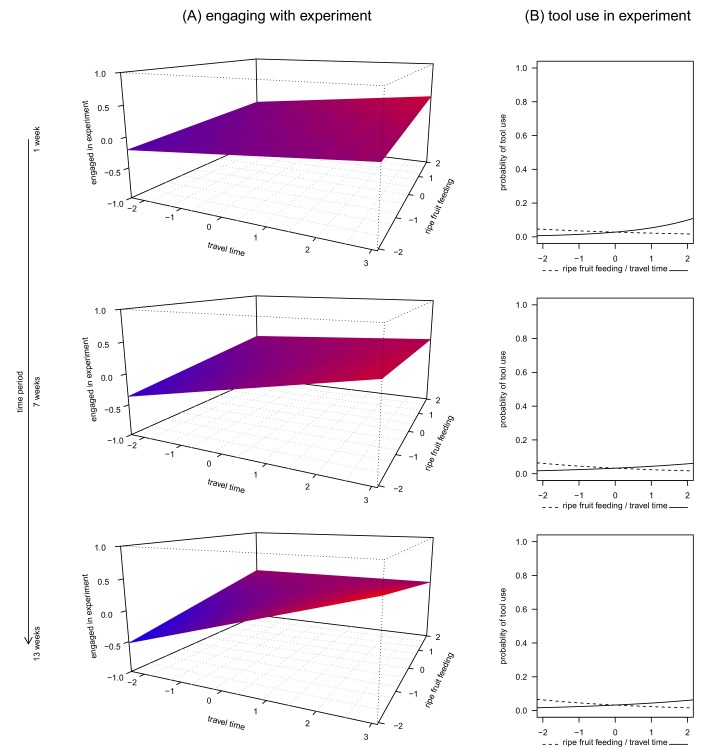
The relationship between ripe fruit feeding, travel time, time period and engagement in the honey experiment (A, Figure 1—source data 1) and ripe fruit feeding, travel time and tool use during the experiment (B, Figure 1—source data 2, 3 and 4).Each panel shows the relationship between ripe fruit feeding, travel time and engagement, respectively use of tools, for time periods of 1, 7 and 13 weeks. All variables were standardized to a mean = 0 and SD = 1. For better readability, colour gradients along the model planes reflect predicted values along the vertical axis (engaged in experiment): larger values appear in red and smaller values in blue.DOI:
http://dx.doi.org/10.7554/eLife.16371.00410.7554/eLife.16371.005Figure 1—source data 1.Engagement data.DOI:
http://dx.doi.org/10.7554/eLife.16371.00510.7554/eLife.16371.006Figure 1—source data 2.Tool data 1 week.DOI:
http://dx.doi.org/10.7554/eLife.16371.00610.7554/eLife.16371.007Figure 1—source data 3.Tool data 7 weeks.DOI:
http://dx.doi.org/10.7554/eLife.16371.00710.7554/eLife.16371.008Figure 1—source data 4.Tool data 13 weeks.